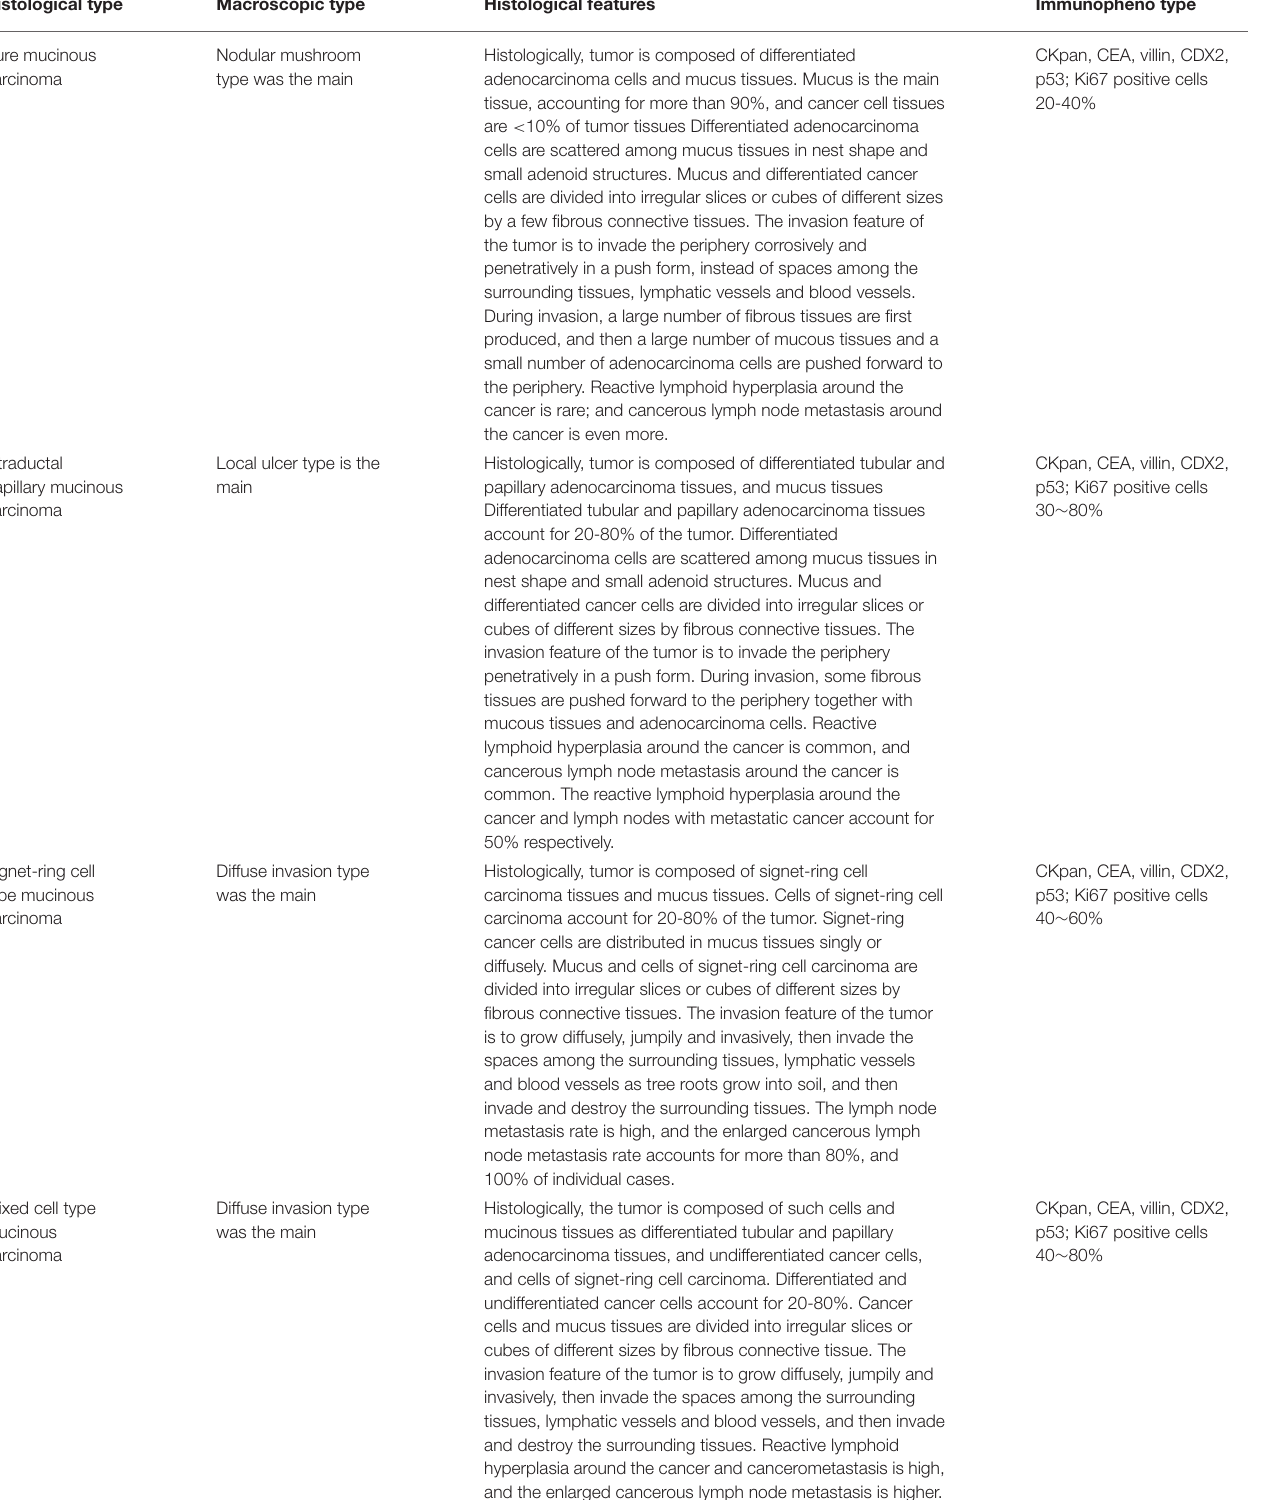
TABLE 3 | Clinicopathologic features of gastric adenocarcinoma with mucinous